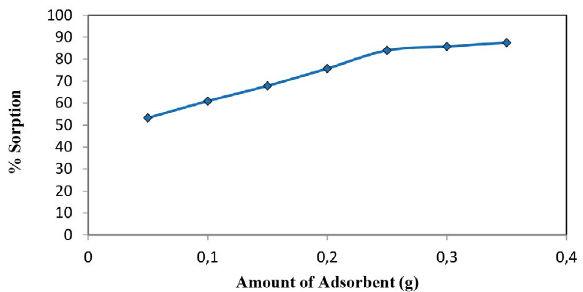
Figure 6. Resin dosage effect for Cr(VI) sorption